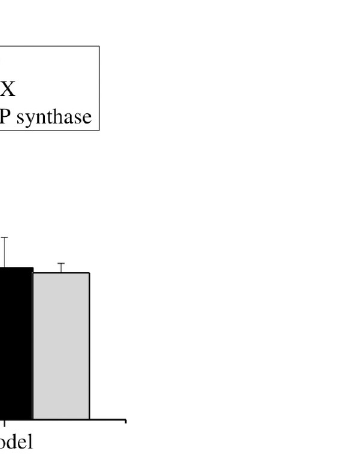
Fig 5. Comparison of the expression of mitochondrial structural protein mRNA in rat macrophages between the two groups.